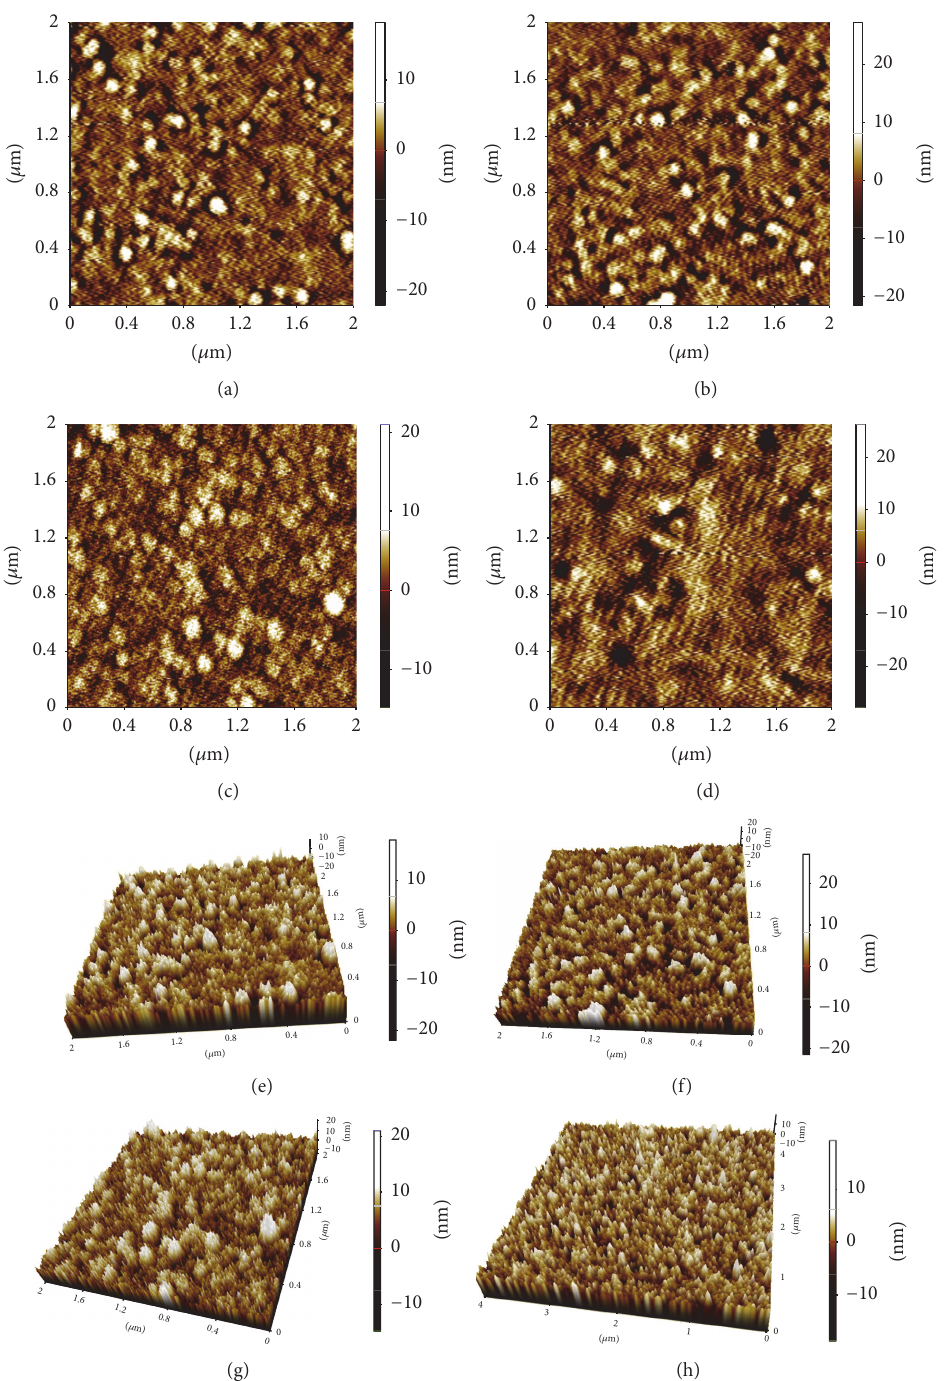
Figure 8: AFM topography spectra of PCPDTTBTT:PCBM blends annealed at different temperatures of 80 ∘ C, 100 ∘ C, and 120 ∘ C for 10min 2 𝜇 m × 2 𝜇 m scan size: (a) no annealing, (b) being annealed at 80 ∘ C, (c) being annealed at 100 ∘ C, and (d) being annealed at 120 ∘ C; AFM 3D spectra of PCPDTTBTT:PCBM blends annealed at different temperatures: (e) no annealing, (f) being annealed at 80 ∘ C, (g) being annealed at 100 ∘ C, and (h) being annealed at 120 ∘